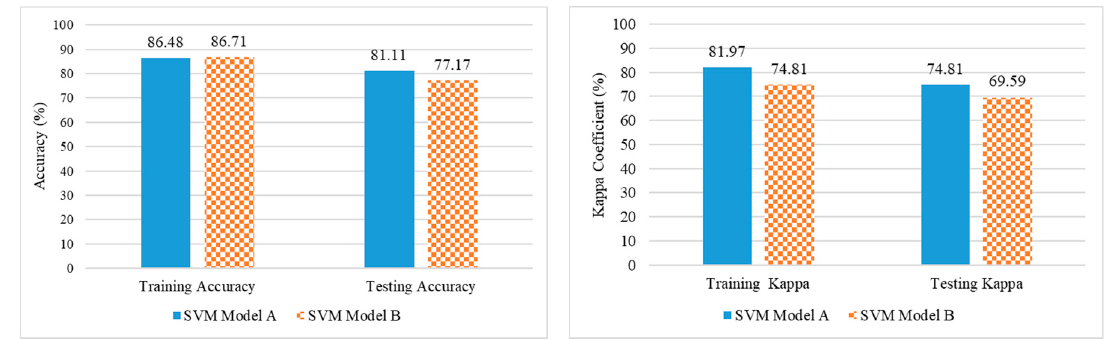
Figure 10. Accuracy assessment of Support Vector Machine (SVM) model on full spectra (SVM Model A) and SVM model on optimal wavelength (SVM Model B).